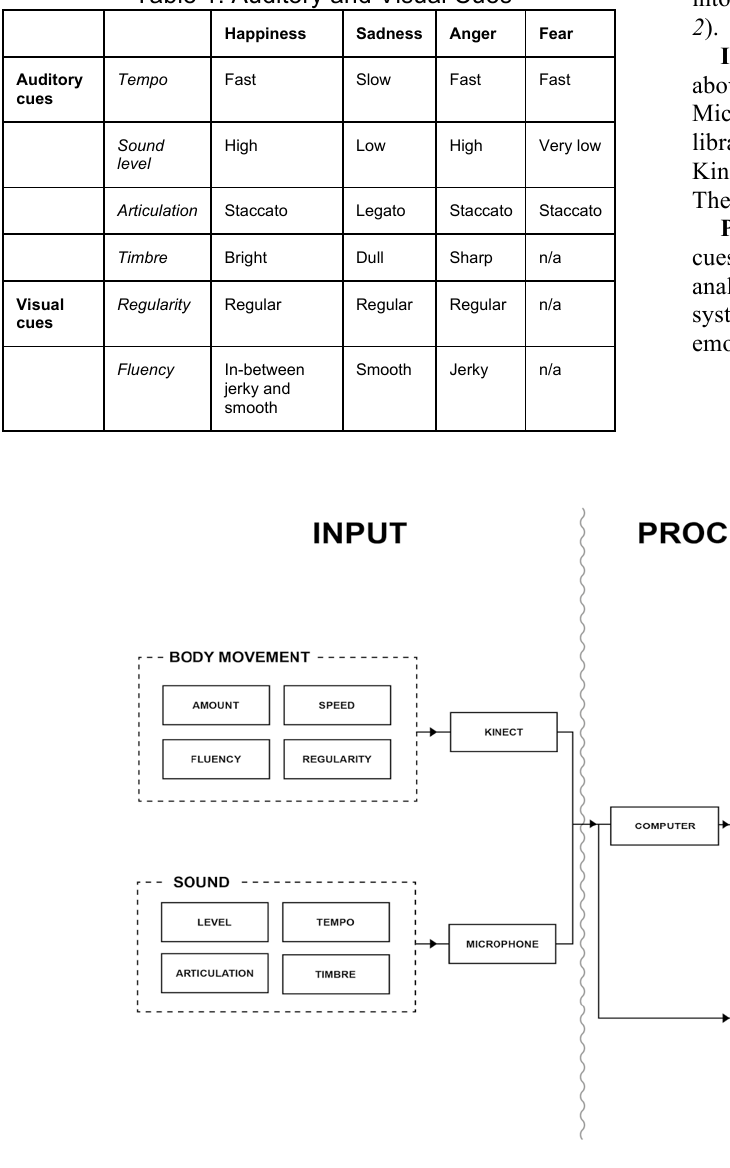
Table 1. Auditory and Visual Cues